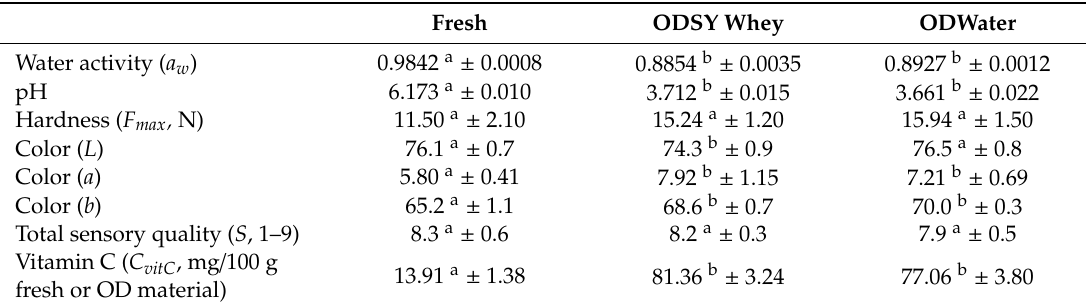
Table 2. Physicochemical and quality parameters (water activity a w , water content X w , pH, hardness F max , color parameters L , a , b , sensory evaluation score for total eating quality S , vitamin C